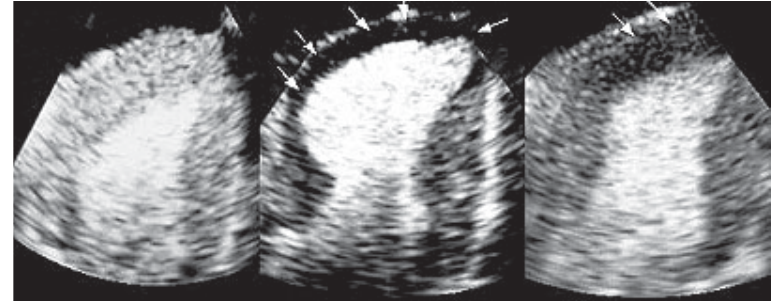
Figure 1. Wall motion abnormality (WMA) and perfusional myocardial defect (PMD) areas determined by real time myocardial contrast echocardiography at baseline, at 180 min of left anterior descend- ing coronary artery (LAD) occlusion and after 30 min of reperfusion in the infarct model. After reperfu- sion there was maintenance of WMA area and reduction of PMD area. *P < 0.05 for baseline vs LAD occlusion; + P < 0.05 for LAD occlusion vs reperfusion (ANOVA).